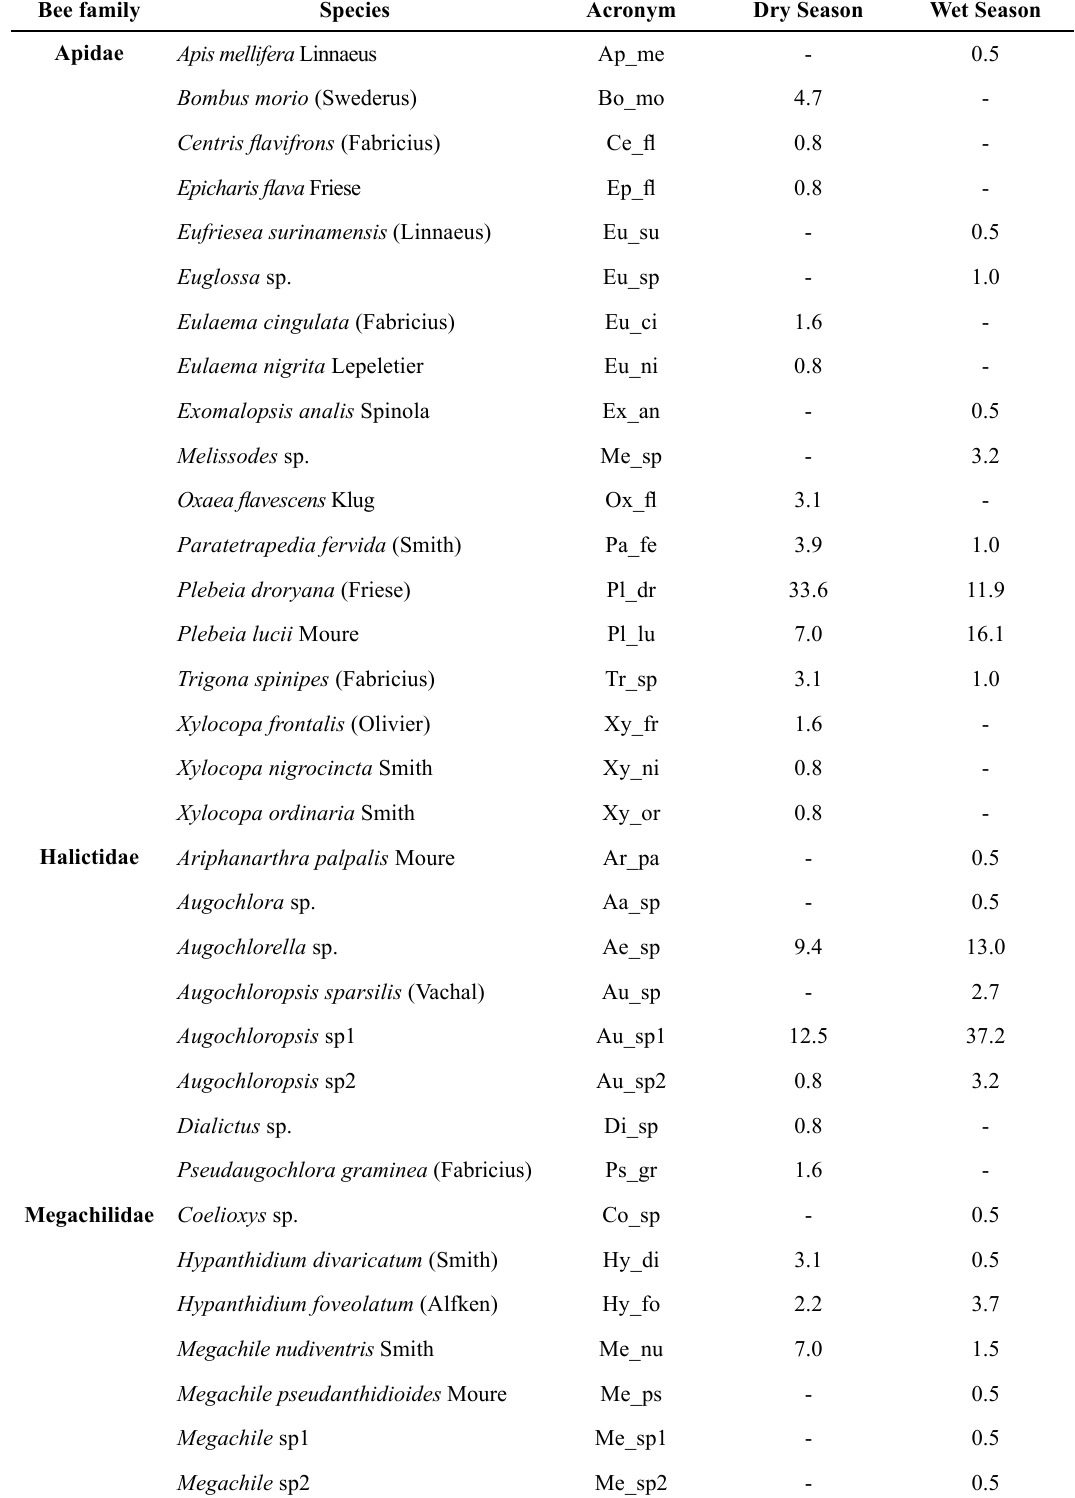
Table 1 . Species composition (and acronyms) and relative abundance (%) of the bees captured in flowers in the dry and wet seasons on the Itaoca Inselberg in the Atlantic Forest in southeastern